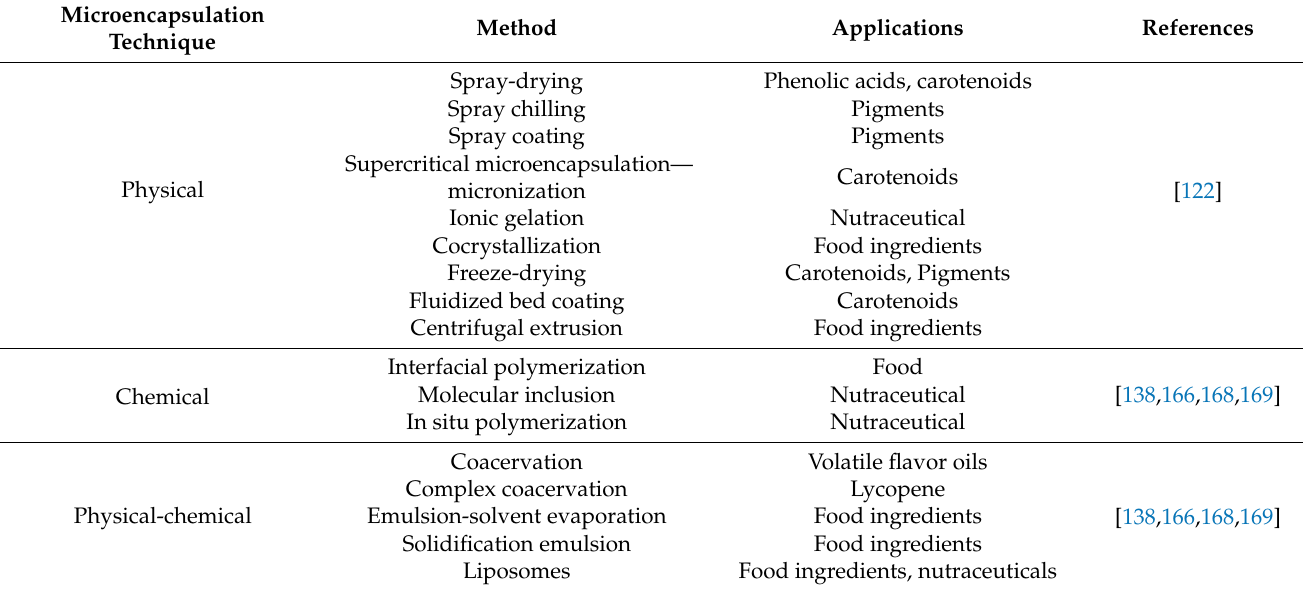
Table 3. Technologies used for the microencapsulation of bioactive